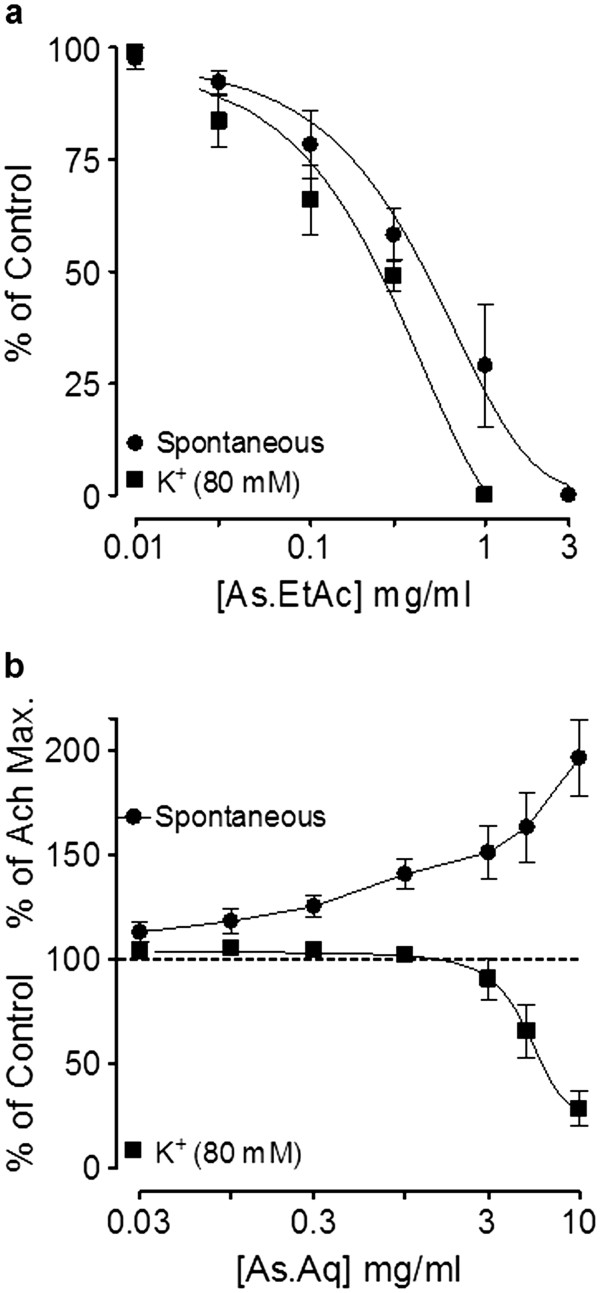
Concentration-dependent effect of (a)ethyl acetate (As.EtAc) and(b) aqueous (As.Aq) fractionsofAmaranthus spinosuson spontaneous and K+(80 mM)-induced contractions inisolated rabbit jejunum. Values shown are mean ± S.E.M., n = 4–5.